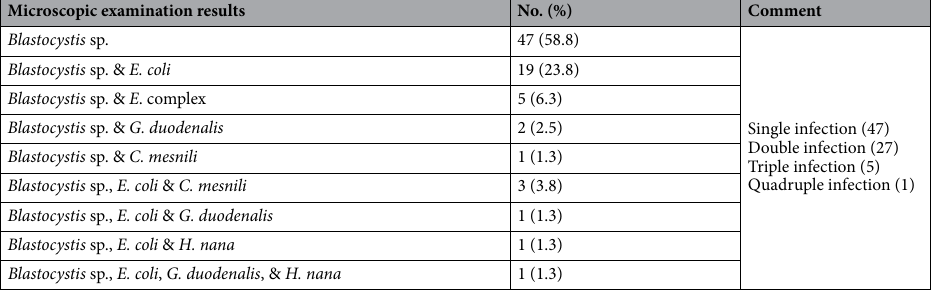
Table 3. Results of microscopic examination for Blastocystis- positive isolates in West Ismailia ( n = 80). Sp.: Species; E. coli : Entamoeba coli ; E . complex: Entamoeba histolytica / dispar / moshkovskii ; C. mesnili : Chilomastix mesnili ; G. duodenalis : Giardia duodenalis ; H. nana : Hymenolepis nana.